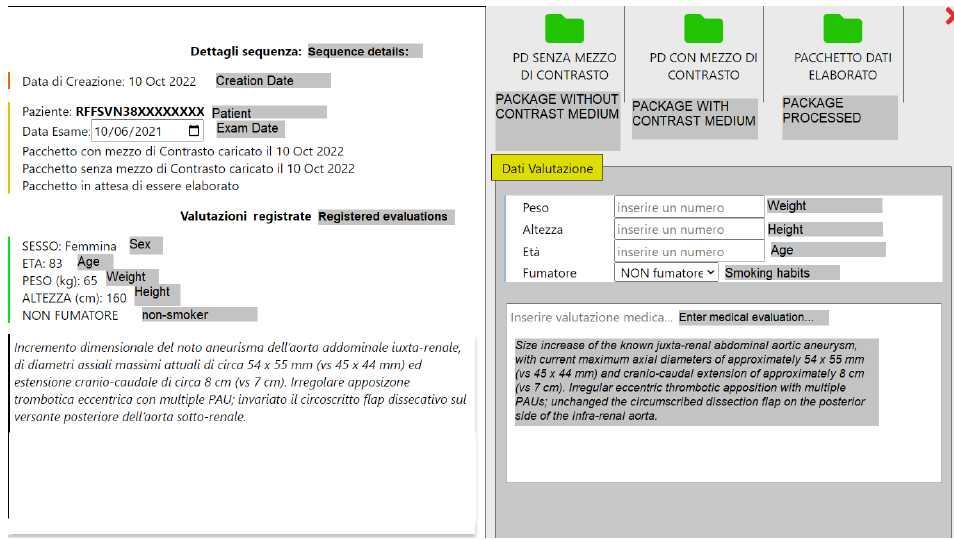
Figure 11. Interface for editing patient data by the medical user.